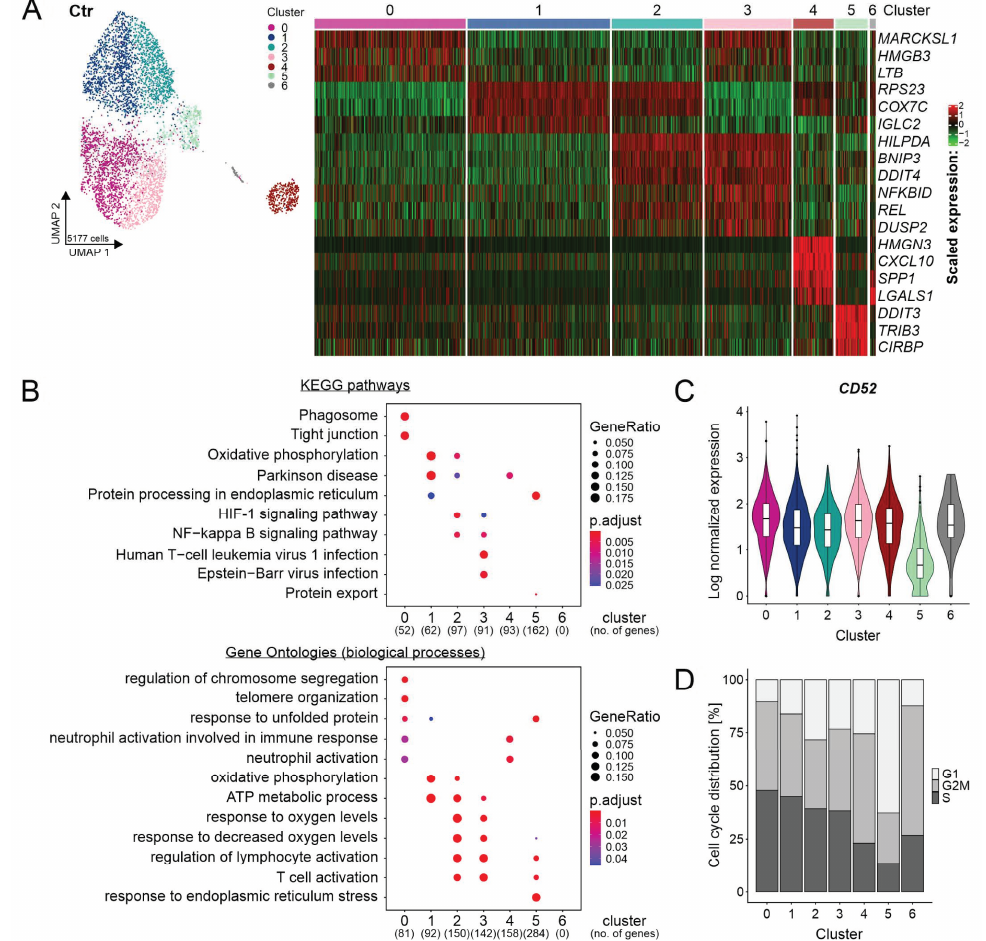
Figure 2. Heterogeneity of REC-1 cell line on the single-cell level. ( A ) Uniform manifold approximation and projection (UMAP) representation visualizing 7 clusters at resolution 0.4 in the integrated and cell cycle regressed data set of untreated cells (Ctr) and the corresponding heatmap showing selected top 10 marker genes (see Table S2 for cluster markers); ( B ) gene set enrichment analysis for Kyoto Encyclopedia of Genes and Genomes (KEGG) pathways and gene ontologies (biological processes) including genes of Ctr with a log fold change > 0.1 and adjusted p -value < 0.001 (no. = number); no matches were detected for cluster 6 due to few differentially expressed genes (DEGs); ( C ) violin plot of CD52 expression in Ctr (clustering is shown in Figure 2A); and ( D ) bar plot showing the proportions of predicted cell cycle phases (G1, G2/M, or S) across clusters of Ctr by Seurat’s cell cycle scoring.